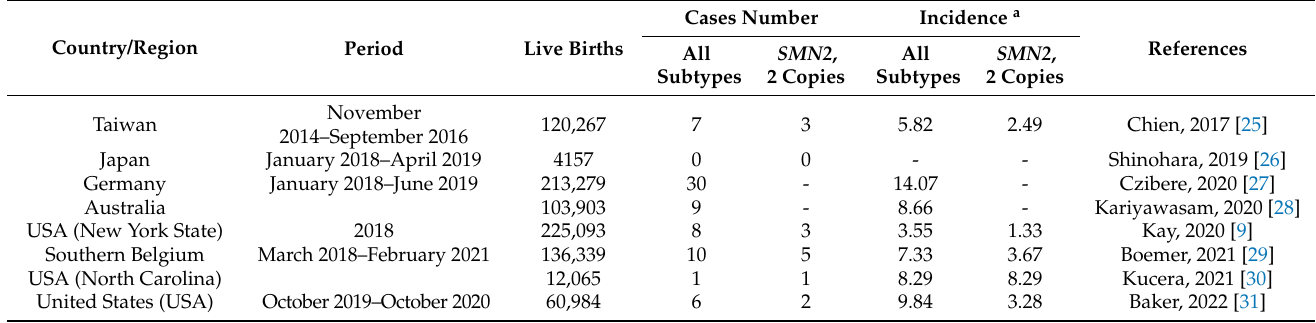
Table 4. Incidence of spinal muscular atrophy determined via newborn